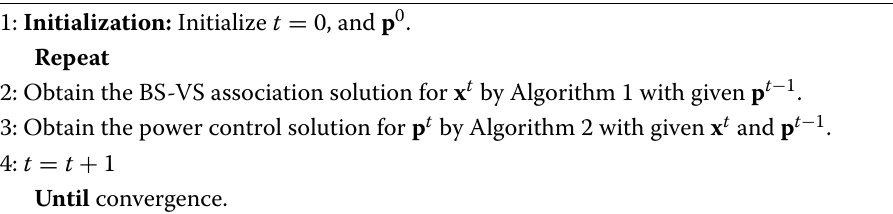
Algorithm 3 The joint optimization algorithm for solving P